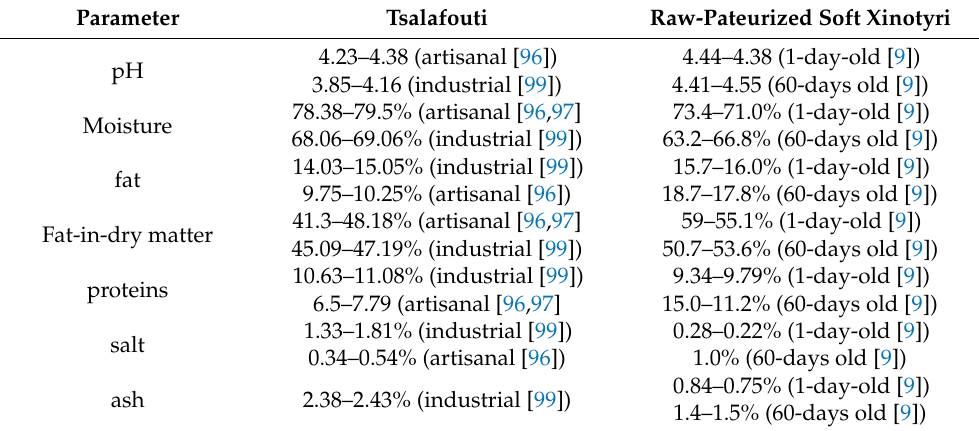
Table 10. Composition of nonprotected designation of origin and nonprotected geographical indica- tion spread